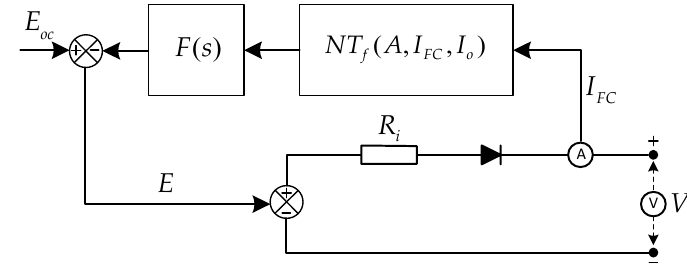
Figure 2. The detailed model of the PEMFC stack.